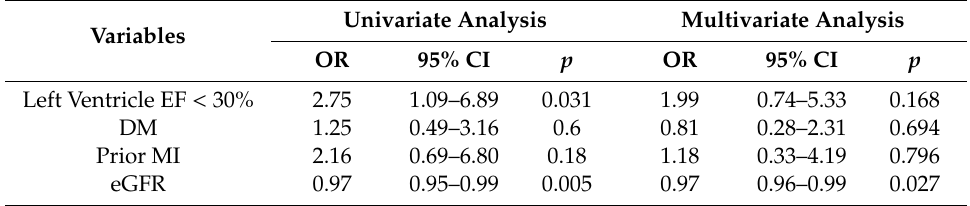
Table 4. Univariable and multivariable logistic analysis for the prediction of 1-year all-cause mortality. Model II: estimated glomerular filtration rate (eGFR) adjusted for left ventricle low ejection fraction ( < 30%), diabetes mellitus, and prior